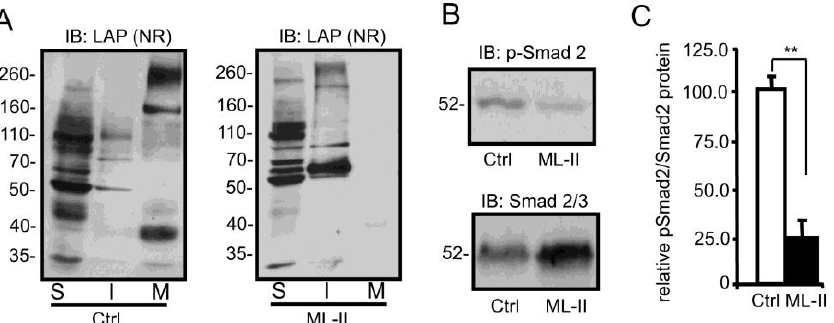
Figure 4. Impaired secretion and increased insolubility and of latent TGF β 1 and reduced TGF β 1 signaling, are also noted in feline ML-II fibroblast-like synoviocytes. ( A ) Western blots of feline control and ML-II cells fractionated into deoxycholate-soluble (S) and – insoluble (I) fractions (n = 3). These fractions and concentrated media (M) from cultures, were resolved by non-reducing (NR) SDS-PAGE and immunoblotted with an antibody against human LAP. ( B ) Western blot analysis of control and ML-II feline fibroblast lysates using antibodies against Smad 2/3 and phosphorylated Smad 2. ( C ) Quantification of the relative intensity of phosphorylated Smad 2 vs. Smad 2/3 protein in control and ML-II cells (n = 3), ** p < 0.01.